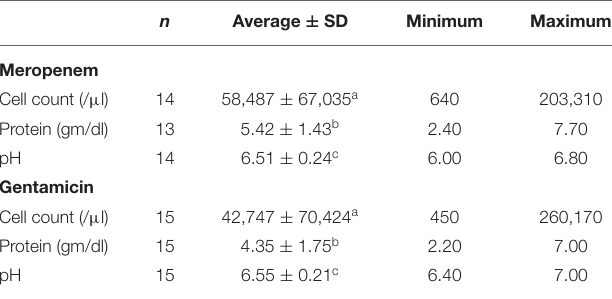
TABLE 3 | Synovial fluid characteristics for groups of horses receiving meropenem (upper) and gentamicin (lower) via intravenous regional limb perfusion